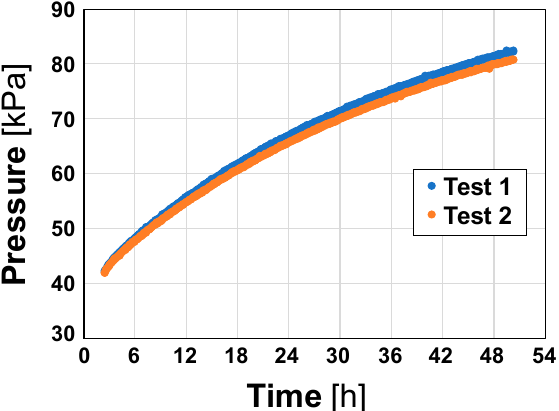
Figure 5. Pressure variation in the test cells over time.